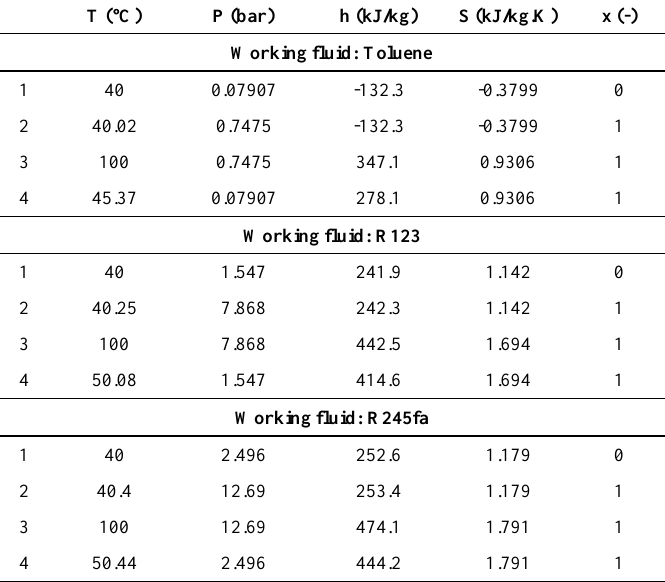
Table 1. Characteristic thermodynamic points of ORC cycle.